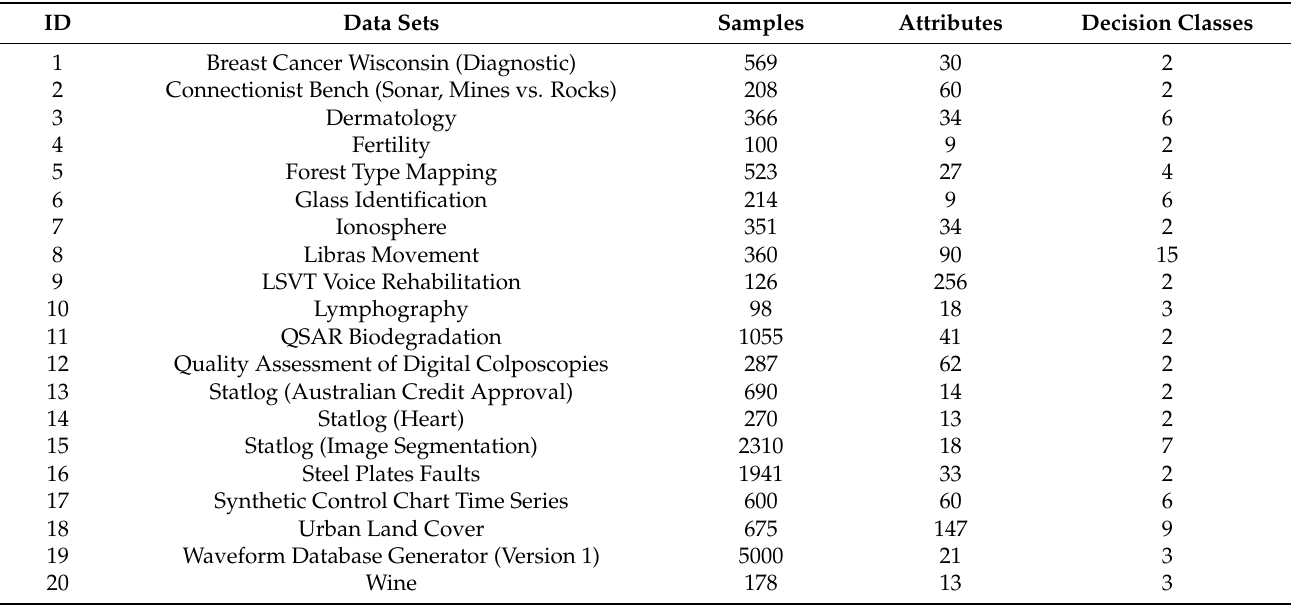
Table 1. Data sets